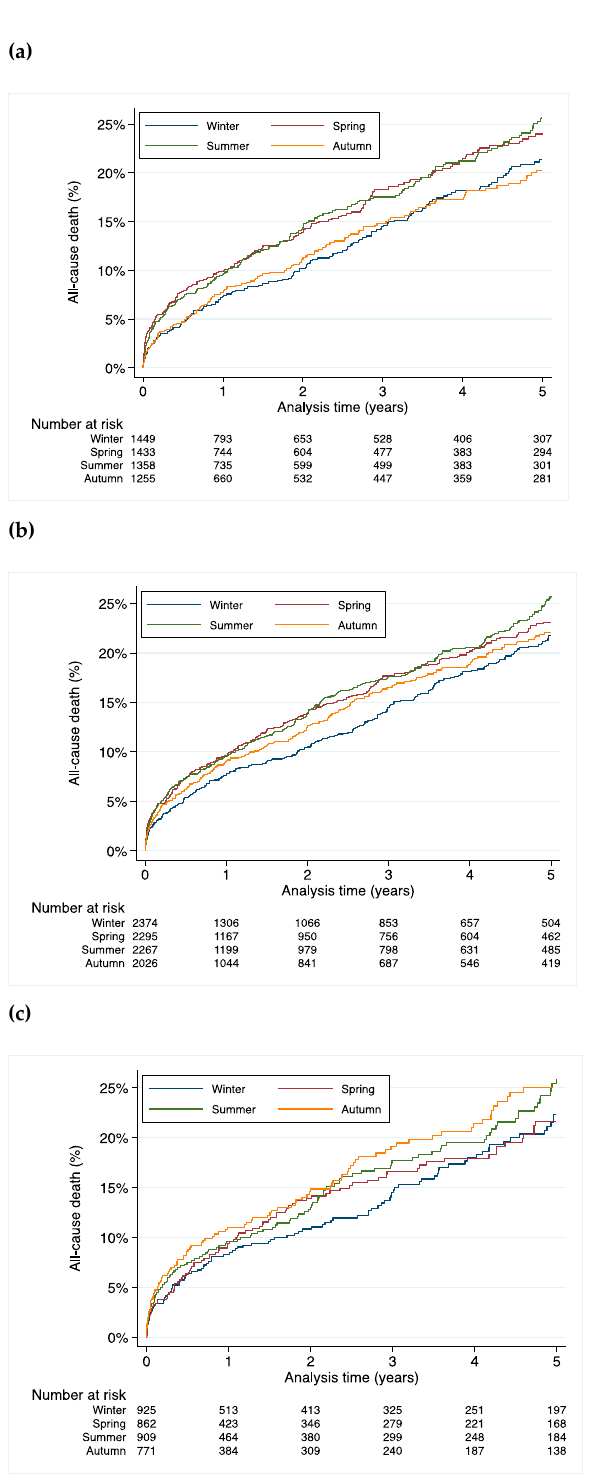
Figure 1. All-cause mortality stratified by season of birth for ( a ) all patients, ( b ) male patients and ( c ) female patients.